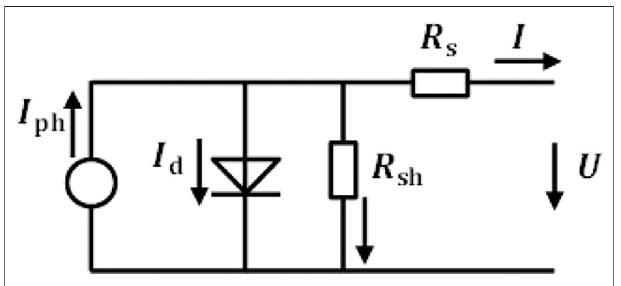
FIGURE 1 | Equivalent circuit of PV